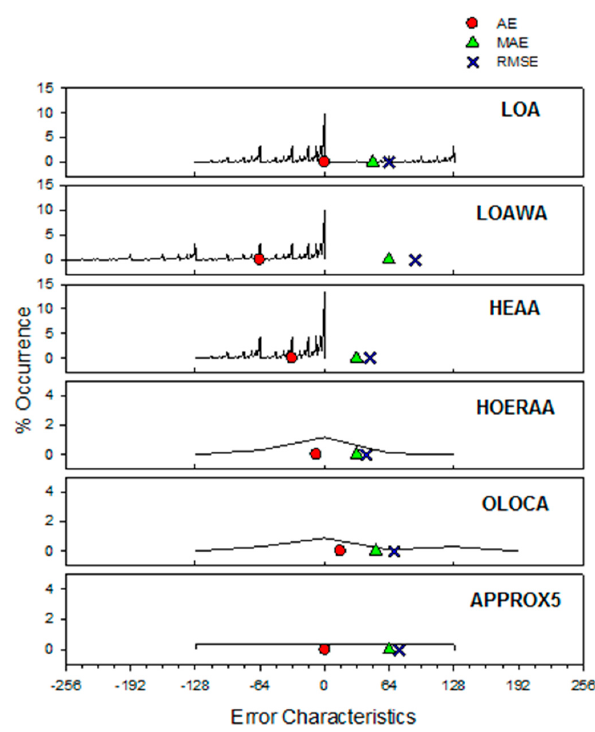
Figure 4. Error distribution of approximate adders about the normal (zero) error.